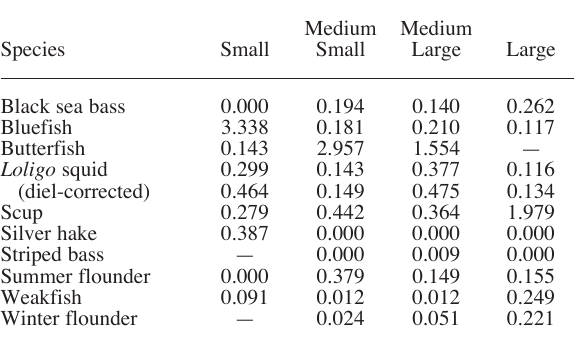
The calculation used the observed, non-area-weighted catch values. Value of 0.000 indicates a ratio